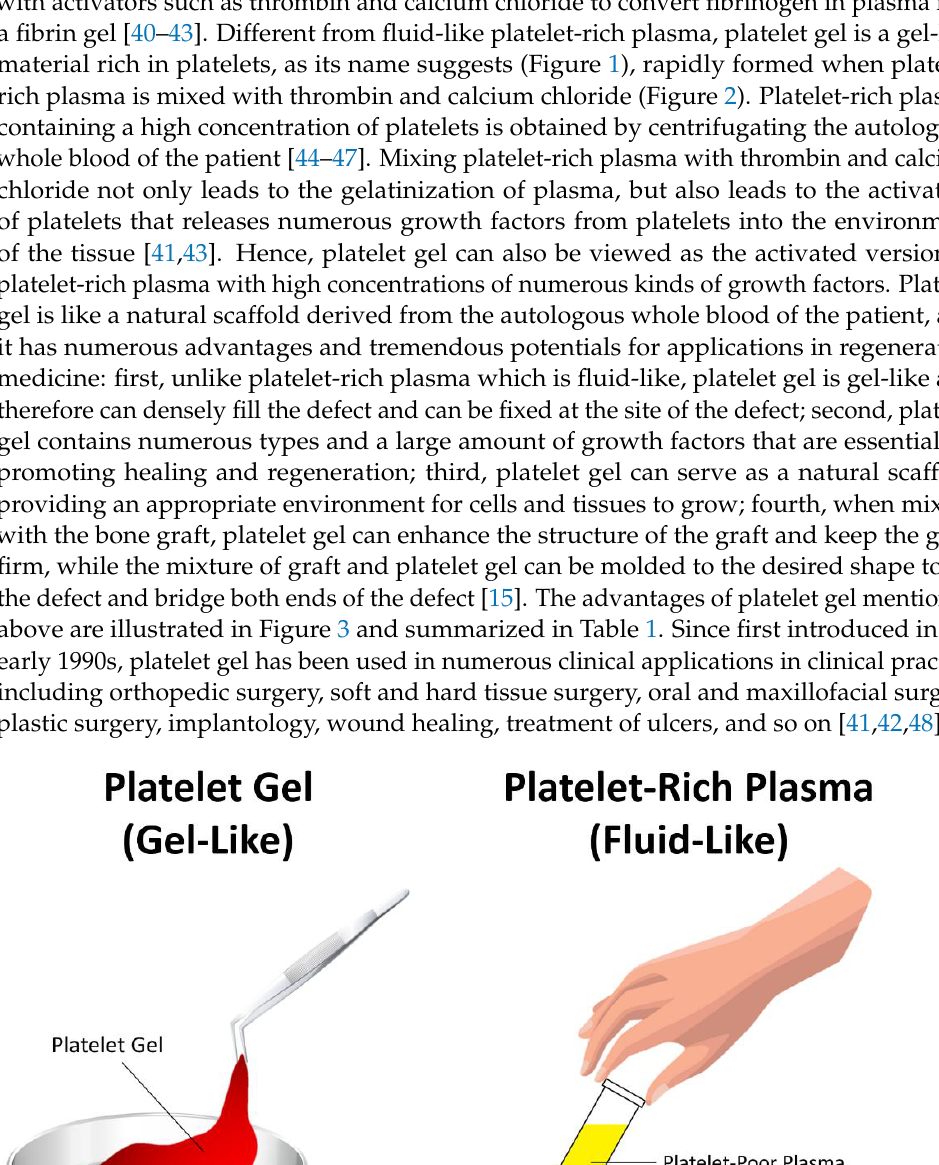
Figure 2. Different from fluid-like platelet-rich plasma, platelet gel is a gel-like material rich in plate- lets as its name suggests and is rapidly formed when platelet-rich plasma is mixed with activators such as thrombin and calcium chloride.